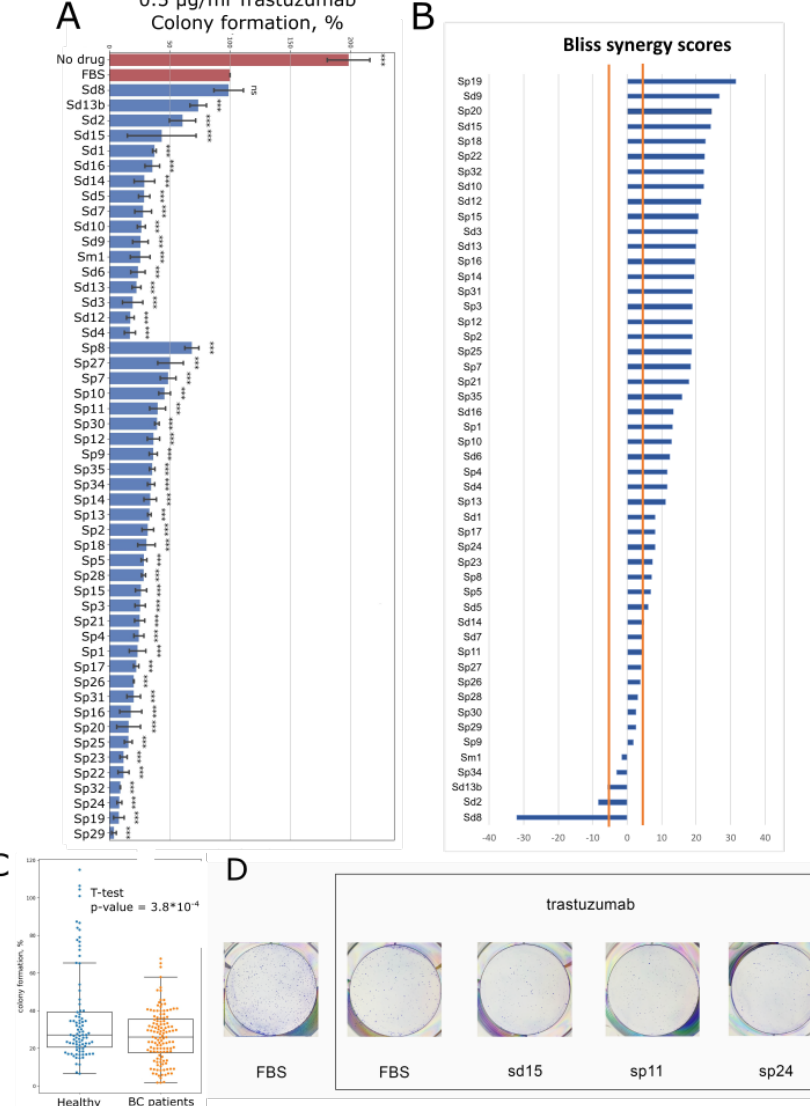
Figure 3. ( A ) BT474 cells colony formation upon the treatment with trastuzumab (0.5 µg/mL) in the presence of 2.5% human blood serum. Samples sd correspond to healthy donors; samples sp corre- spond to HER2+ BC patients. FBS shows clonogenicity in the presence of 12.5% of heat-inactivated FBS only. Colony formation is normalized to the growth media containing only 12.5% heat-inactivated FBS and trastuzumab (FBS). No drug represents clonogenicity without drug and human sera. The data are presented as mean ± standard deviation from three independent replicates (see Table S2). ( B ) Influence of human blood serum on trastuzumab inhibition of BT474 cells colony formation. Bliss synergy scores (BS) for serum and trastuzumab interaction were calculated using the data presented in Figures 1 and 3A. If synergy score BS < − 5, the interaction is thought antagonistic; if BS > 5, the interaction is thought synergistic; while at BS between − 5 and 5, it is thought additive [57–59]. ***— p -value < 0.001; ns—non-significant. ( C ) BT474 cells colony formation upon the treatment with trastuzumab (0.5 µ g/mL) in the presence of 2.5% human blood serum from healthy donors (blue) vs. BC patients (orange). ( D ) Representative photographs of stained clonogenicity assay results were used for colony number